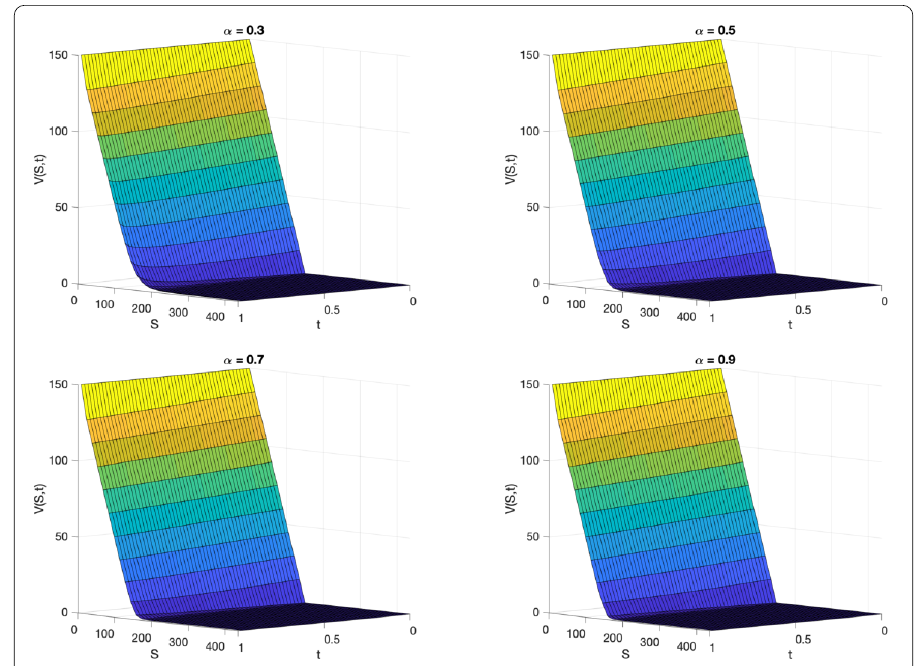
Figure 4 Payoffs under Example 5.1 for α = 0.3,0.5,0.7,0.9; δ = 0.025, for all 0 ≤ t ≤ T